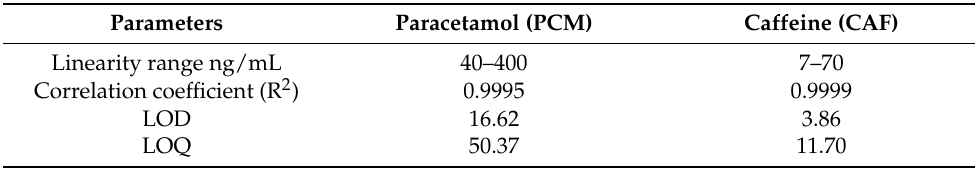
Figure 7. Calibration curve of CAF. Table 1. Linear regression analysis for the concurrent quantification of PCM and CAF via